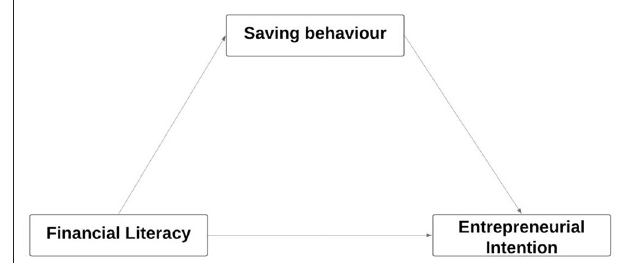
FIGURE 1 | Study model. Source: Authors’ elaboration.